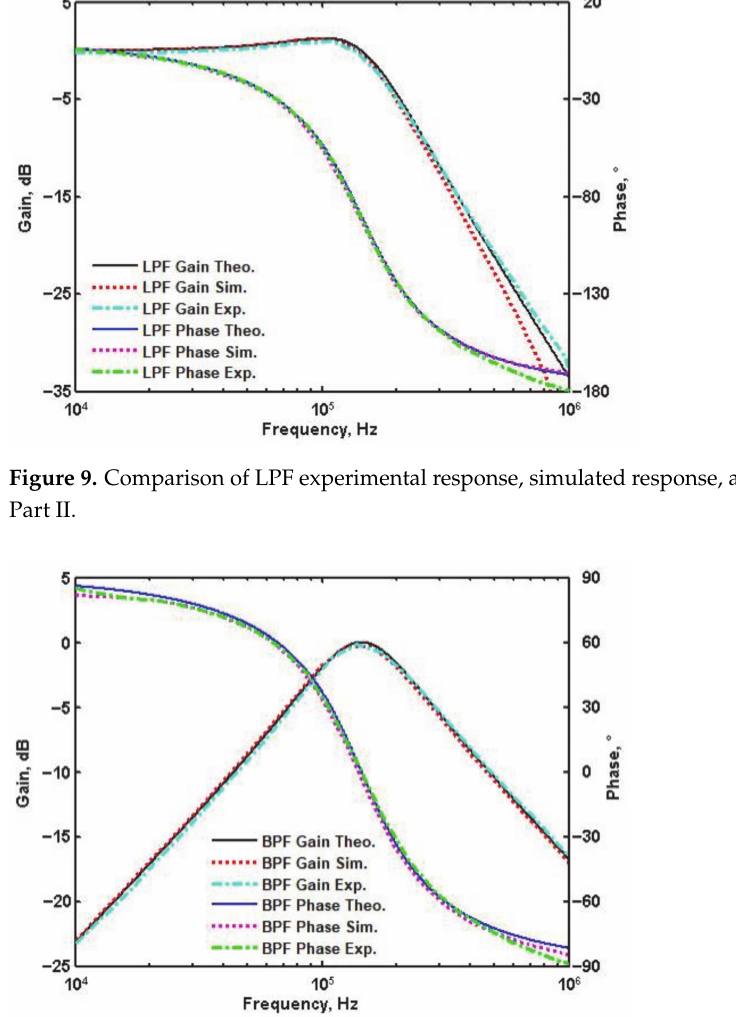
Figure 10. Comparison of BPF experimental response, simulated response, and theoretical response in Part